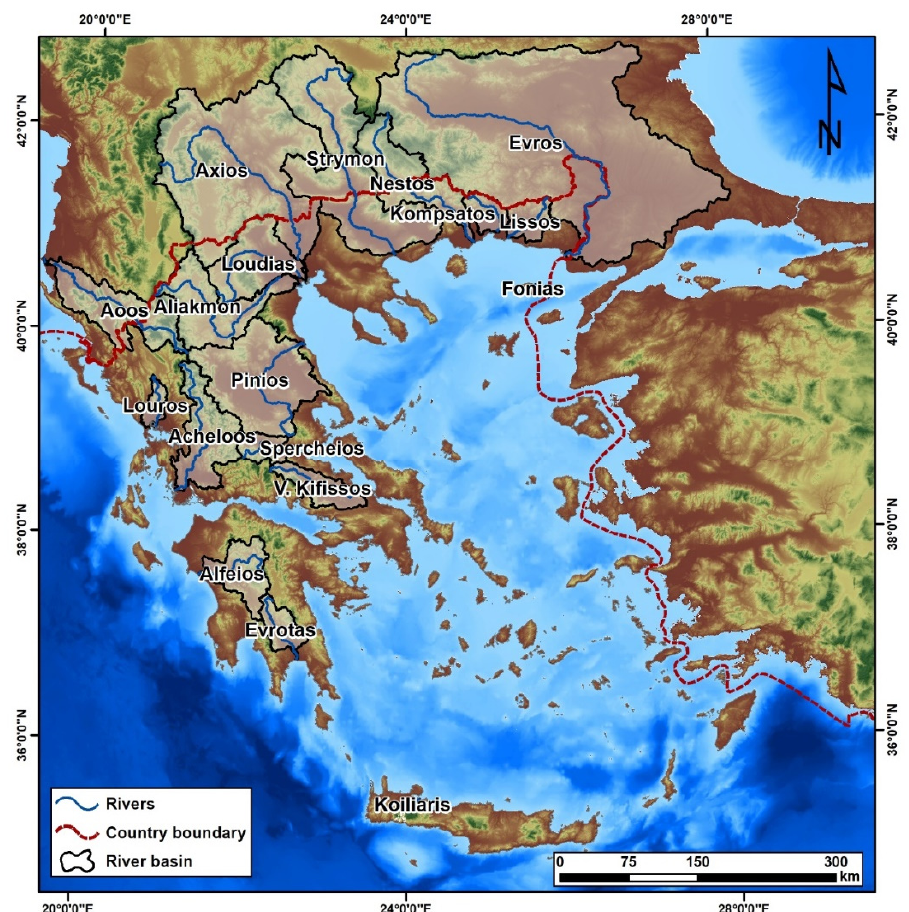
Figure 1. The examined river basins.